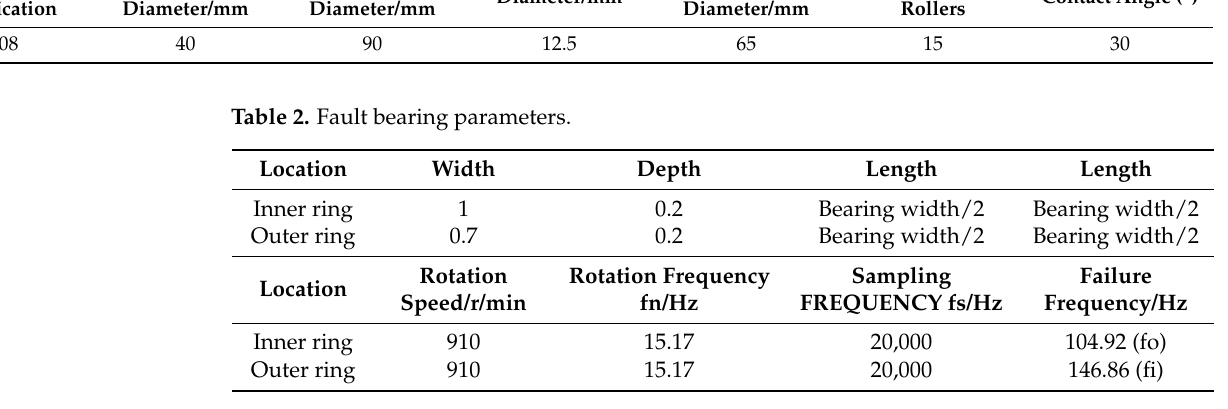
Table 1. Bearing-related parameters. Table 1. Bearing ‐ related parameters.